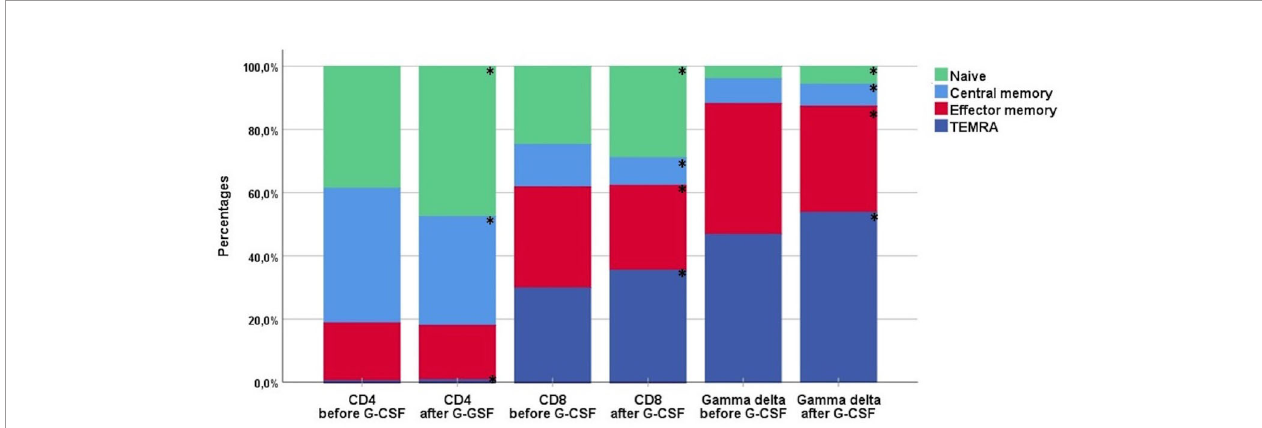
FIGURE 1 | The distribution of differentiation subsets of CD4, CD8, and TCR gd cells before and after G-CSF stimulation in peripheral blood of healthy donors, n=49. Each compartment is constructed by the use of median percentages. TEMRA; terminally differentiated effector memory. *Statistically signi fi cant (p < 0.05) changes in distribution by per cent between before- and after-G-CSF stimulation for each